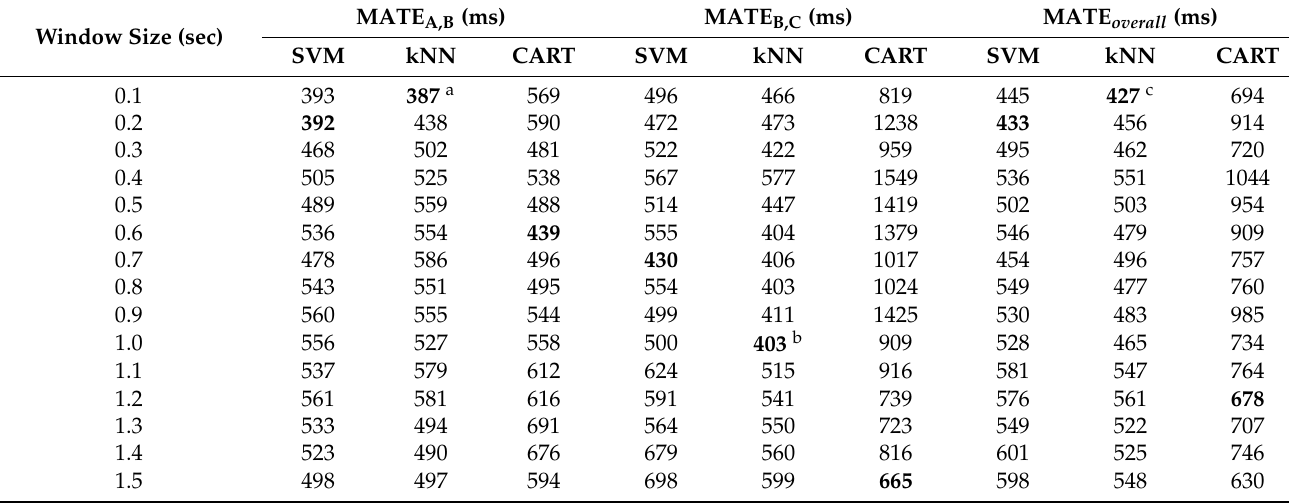
Table 8. The MATE A,B , MATE B,C and MATE overall of all subject using different machine learning models vs. difference window sizes (s). Window Size